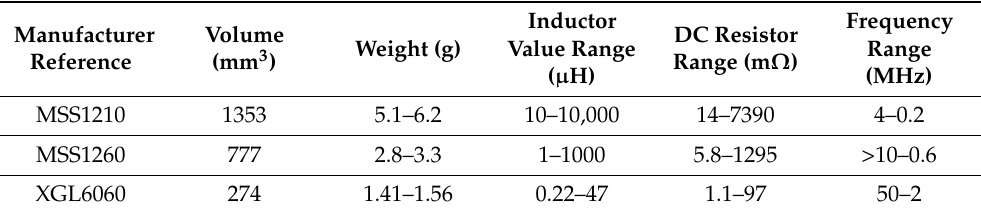
The three series pictured in Figure 2 are mapping a wide range of high-frequency inductor values and current saturation as illustrated in the plot in Figure 3. With this set of converters in the range of a few tens of volts and amps, leading to converters from tens to hundreds of watts. Maximum energy density can be derived with Equations (1) and (2). In